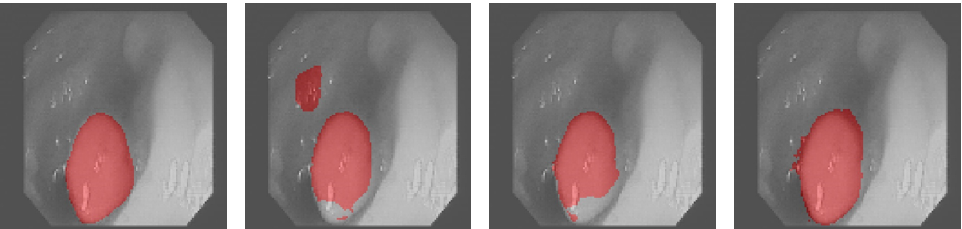
Figure 6. Qualitative results obtained for the colonoscopy images. From left to right: ground truth, U-Net, Att-UNet, and SAB-Net.